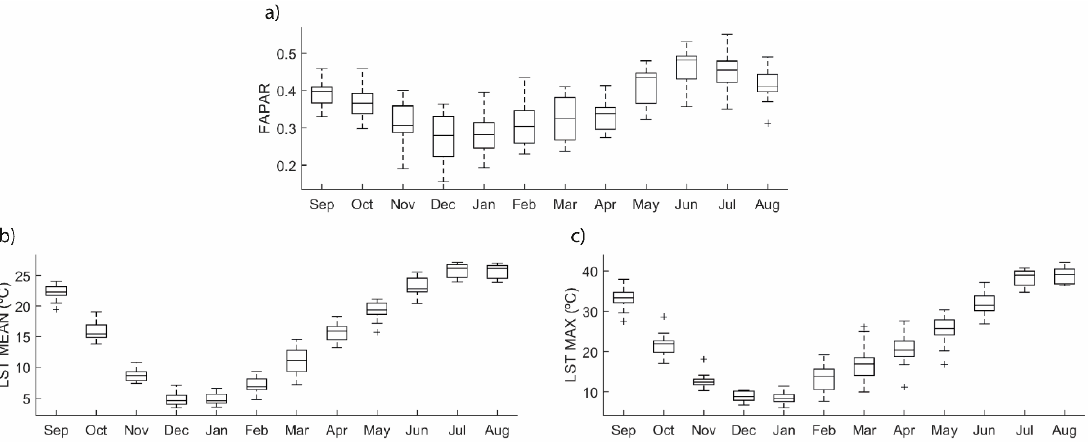
Figure 4. Annual cycle of the satellite data from the pixels selected as vineyards in the DDR: ( a ) FAPAR; ( b ) LST MEAN and ( c ) LST MAX. Boxes represent upper and lower quartiles, including median as central line. The whiskers stating the lowest and highest observed value within 1.5 of the interquartile range. The outliers represented by + correspond to the values beyond the ends of the whiskers.